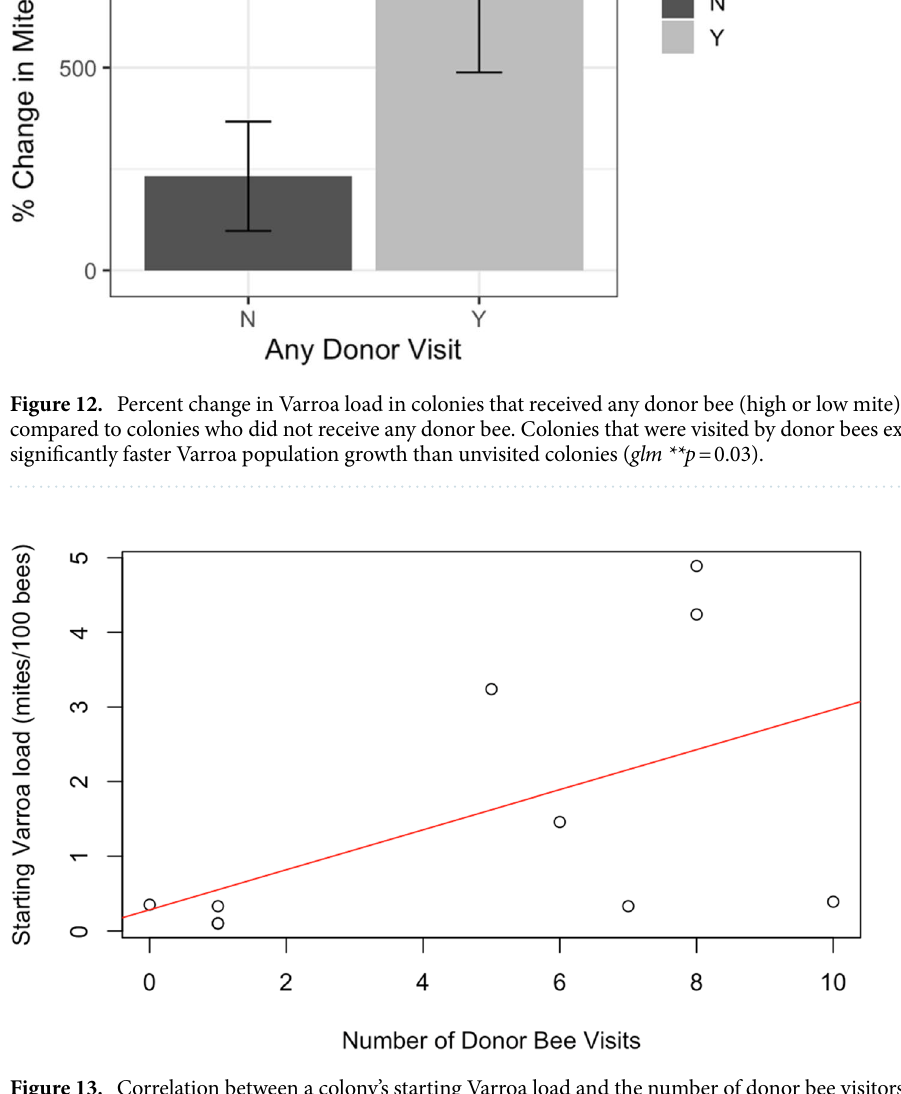
Figure 13. Correlation between a colony’s starting Varroa load and the number of donor bee visitors it received. Colonies with higher starting Varroa loads received more visitors than colonies with lower starting Varroa loads ( Spearman’s r = 0.62, p =